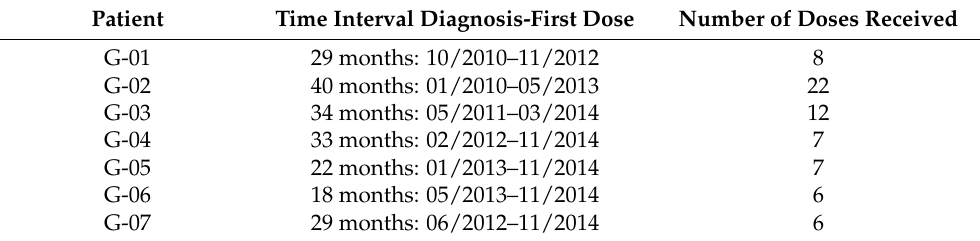
Table 2. Interval between diagnosis and first vaccine and total number of vaccinations.